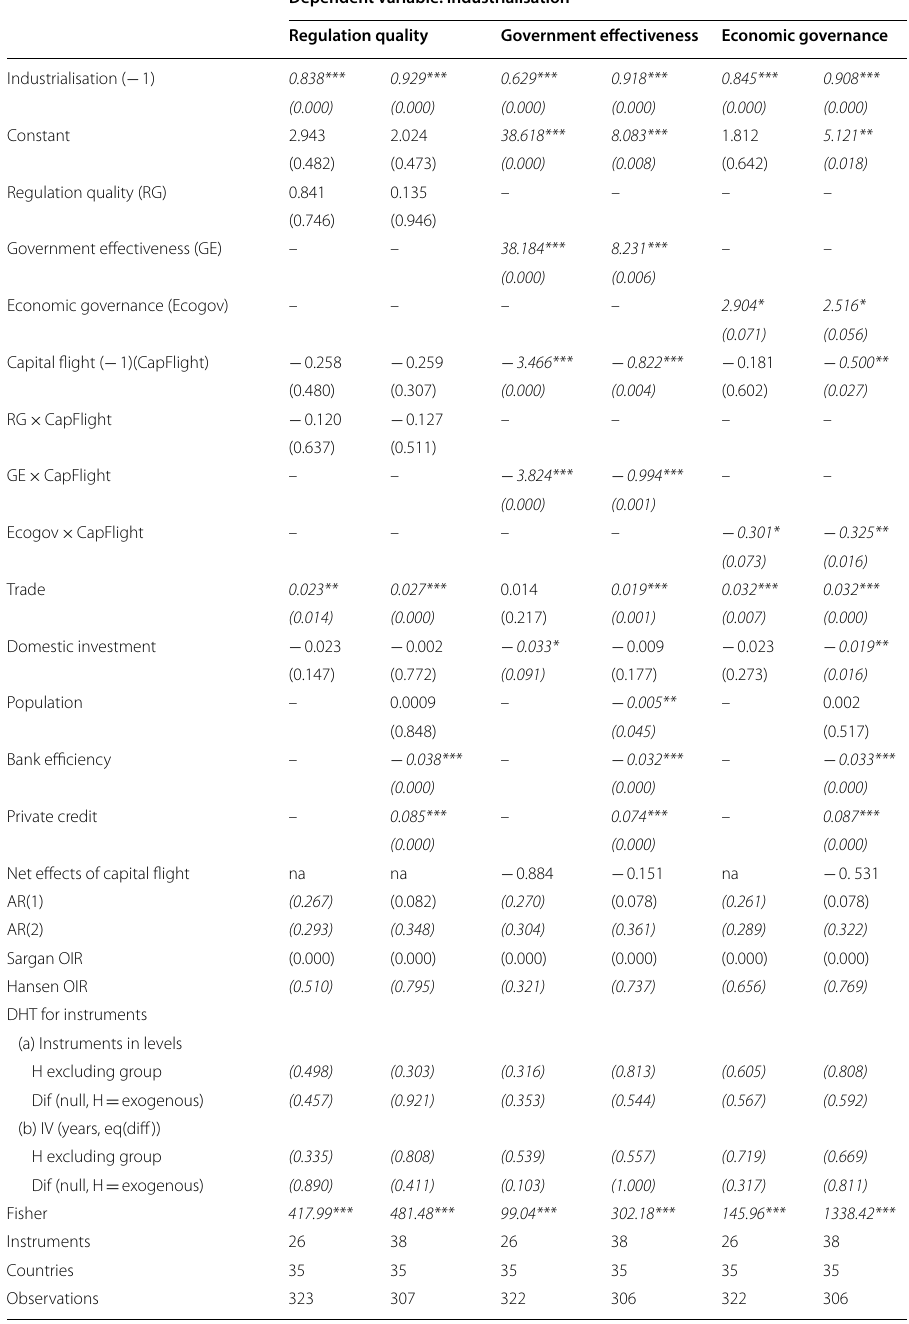
Table 3 Economic governance, capital flight and